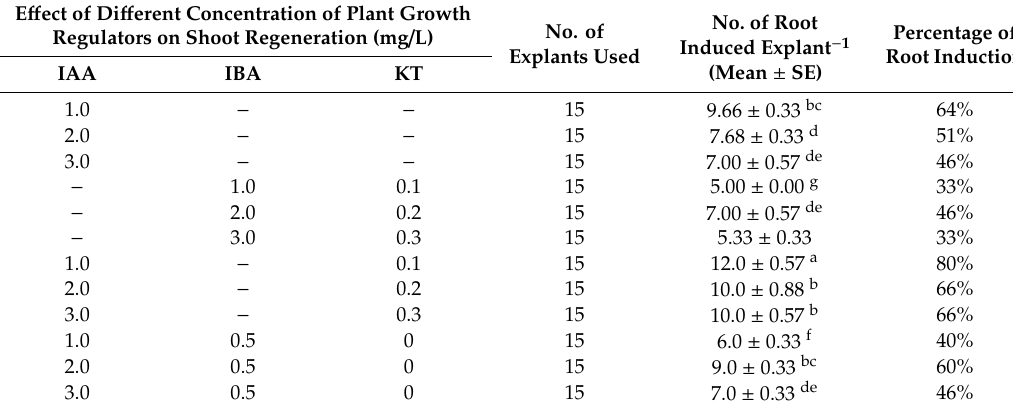
Table 2. E ff ect of di ff erent concentrations of Indole acetic acid (IAA), Indole butyric acid (IBA), and Kinetin (KT) on root induction. Di ff erent alphabetic letters show significant di ff erences among all combinations used for shoot regeneration in white lupin. E ff ect of Di ff erent Concentration of Plant